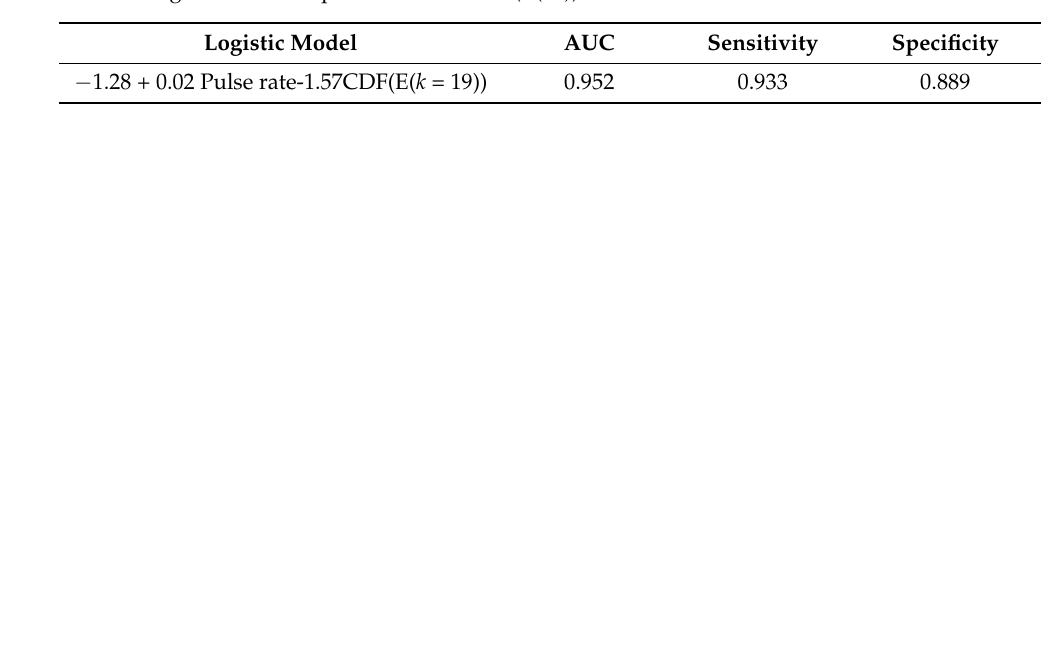
Table 6. Logistic model of pulse rate and